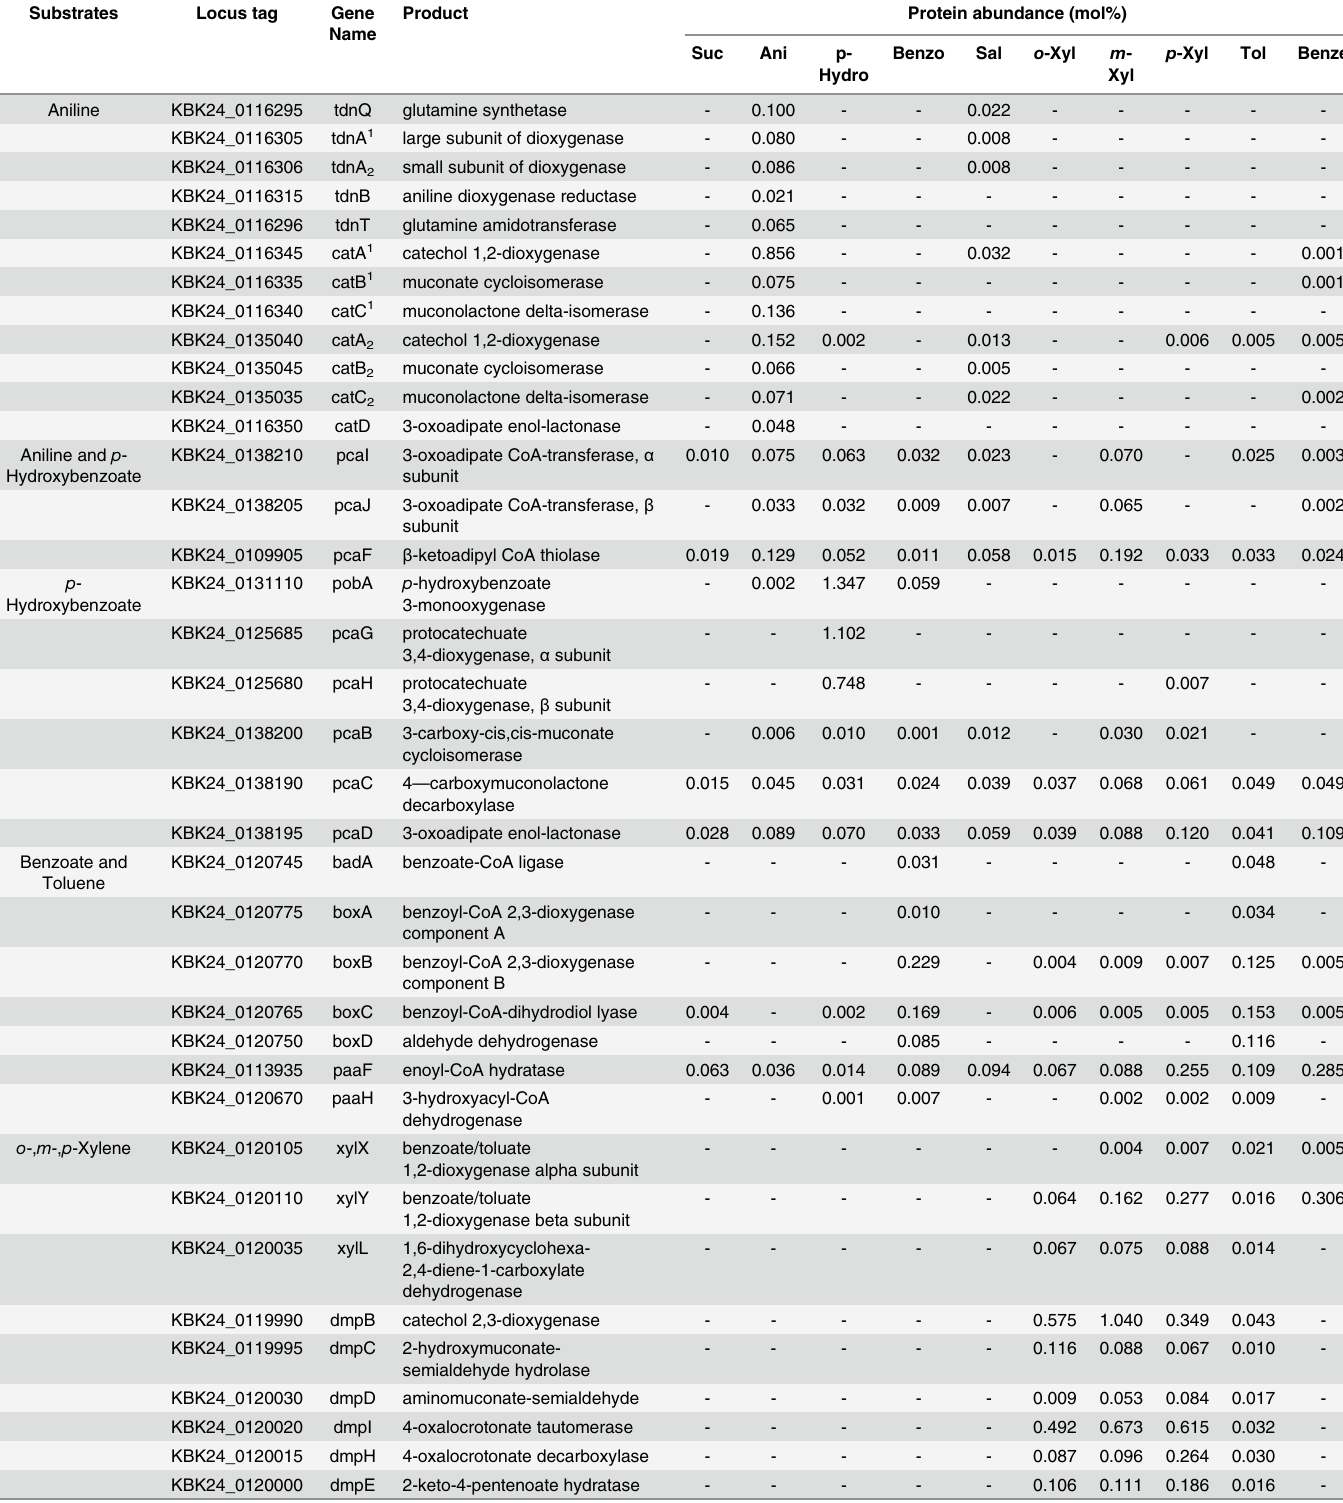
Table 3. Summary of differential proteomic expression of Burkholderia sp. K24 cultured in monocyclic aromatic hydrocarbons.